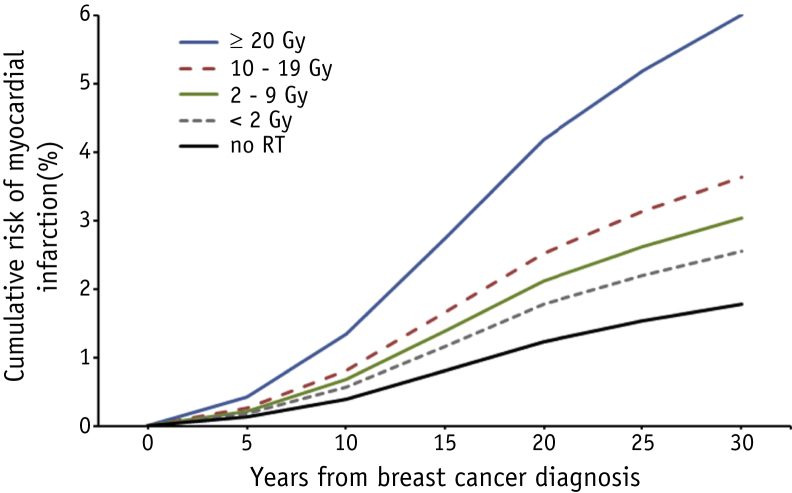
Modeled cumulative myocardial infarction risk for cases by categories of mean whole heart dose. Cumulative risks of myocardial infarction (MI) as a first cardiac event among women diagnosed with breast cancer (BC) when aged ≤70 years (median age at BC diagnosis, 50.2 years (interquartile ratio [IQR], 45.8-54.7) and median age at MI diagnosis, 64.1 years (IQR, 58.5-70.2)) by time since initial BC treatment for categories of mean whole heart dose. Cumulative risks were calculated from the MI rate ratios for different dose categories (Table 2) and the cumulative MI risk for the entire BC cohort in which this study is embedded, with death as a competing event. Abbreviation: RT = radiation therapy.